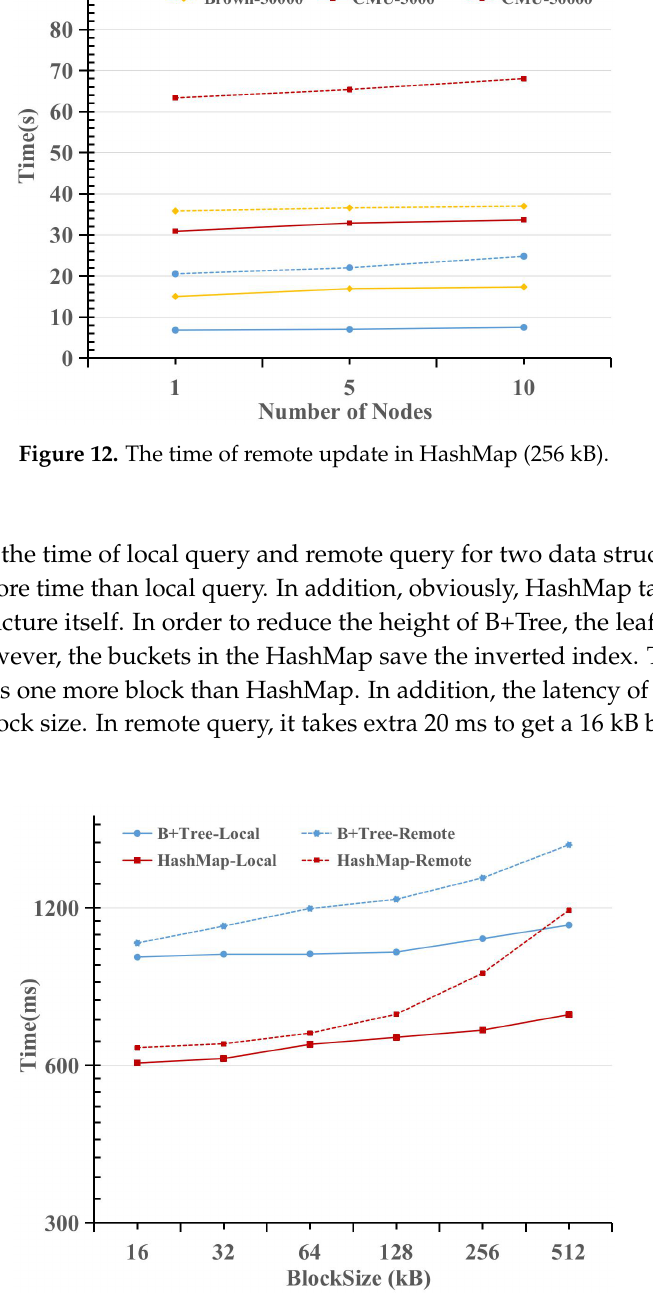
Figure 13. Comparison of the query time between B+Tree and